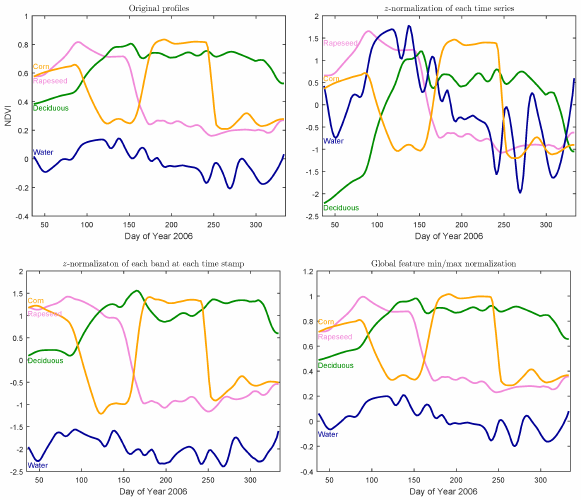
Figure 3. Normalisation taken from (Pelletier et al.,